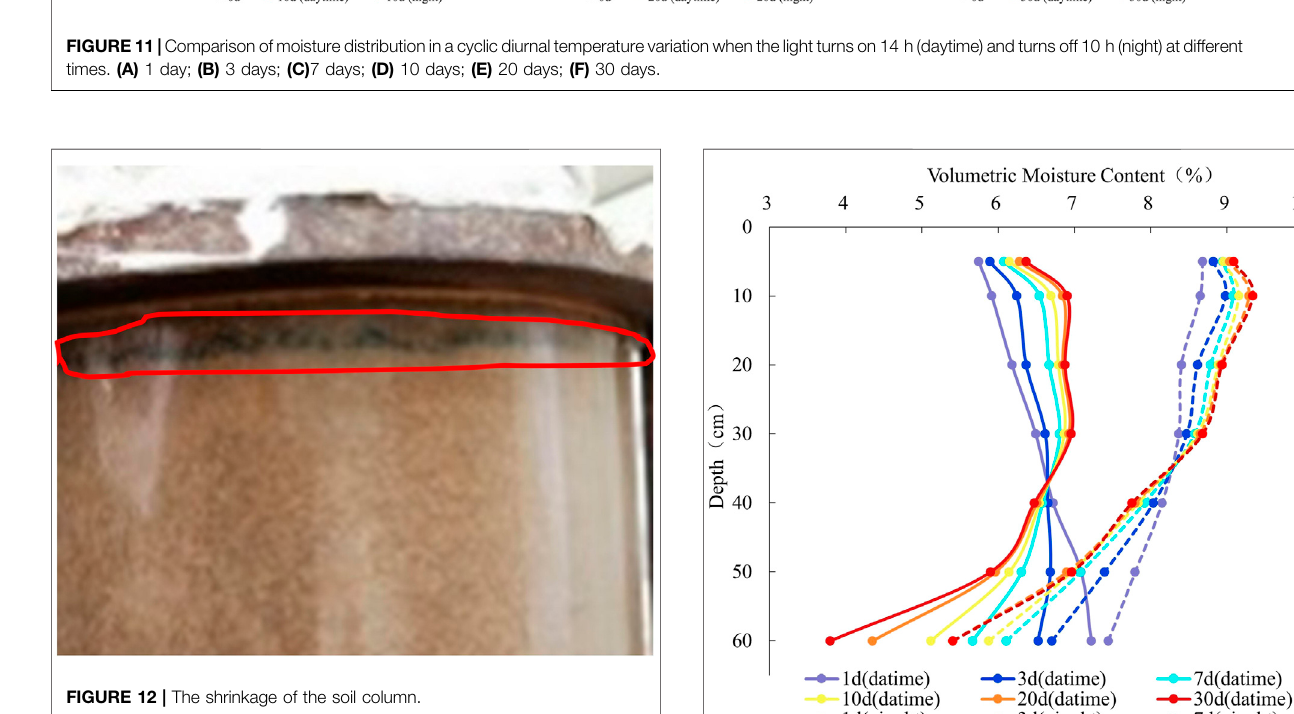
FIGURE 12 | The shrinkage of the soil column.